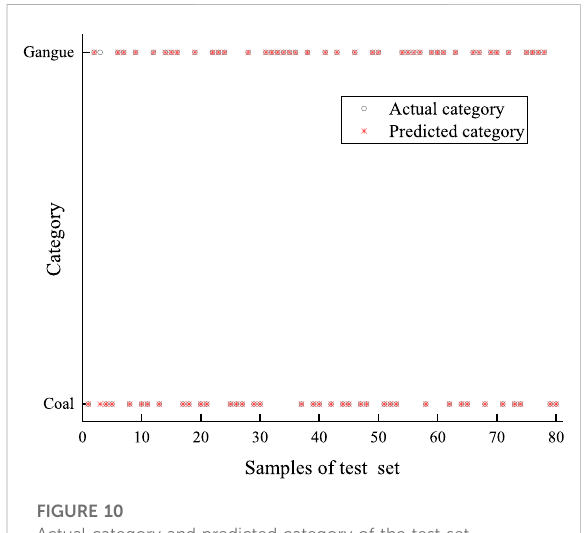
FIGURE 10 Actual category and predicted category of the test set.